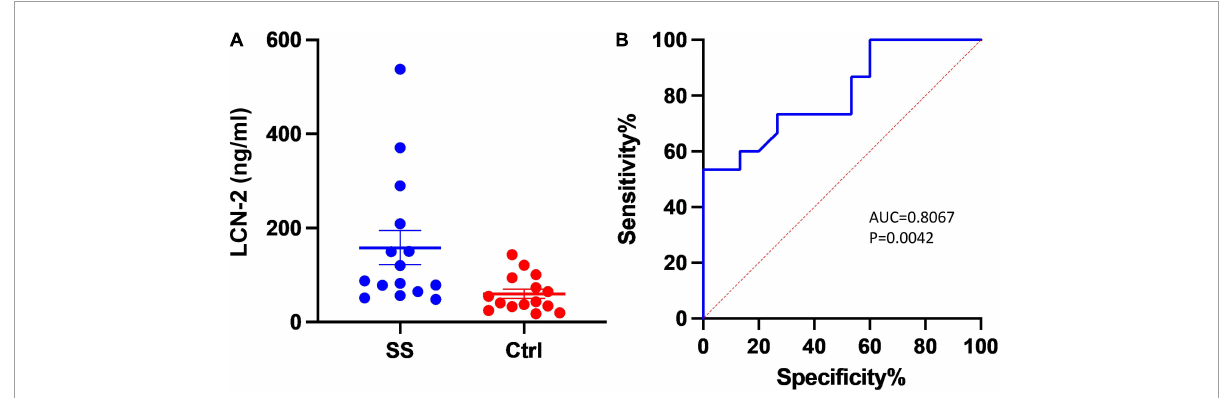
FIGURE1 Plasma level of LCN-2 between groups. (A) Scatter plots of plasma LCN-2 levels. (B) The receiver operating characteristic analysis (ROC) of LCN-2 to predict severe sepsis and sepsis shock. AUC, Area under curve; Ctrl, Controls; SS, Severe